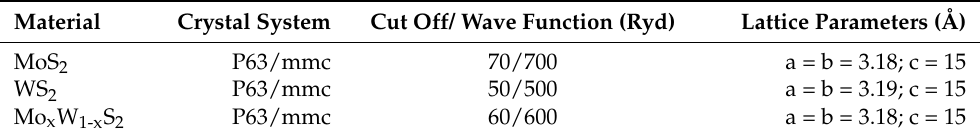
Table 1. Crystal systems, cut off wave function and cell parameters implemented in DFT calculations.